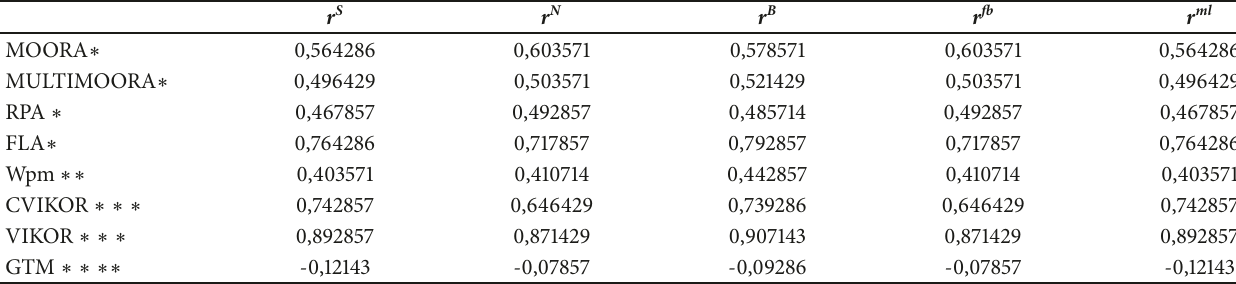
Table 2: Correlation between methods.